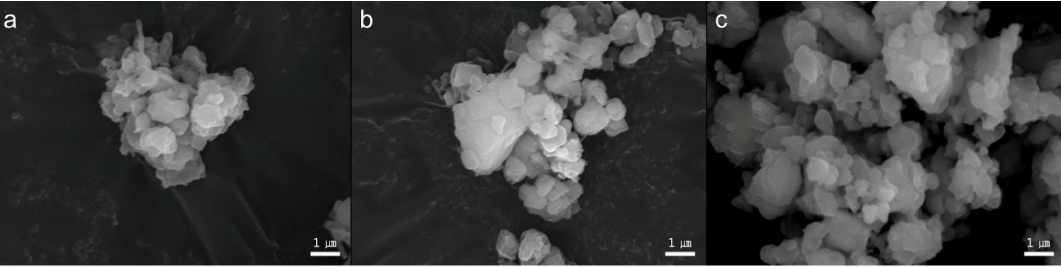
Figure 2. The morphology for three different types of BAG: ( a ) 45S5 BAG particles; ( b ) 45S5F BAG particles; and ( c ) S53P4 BAG particles.